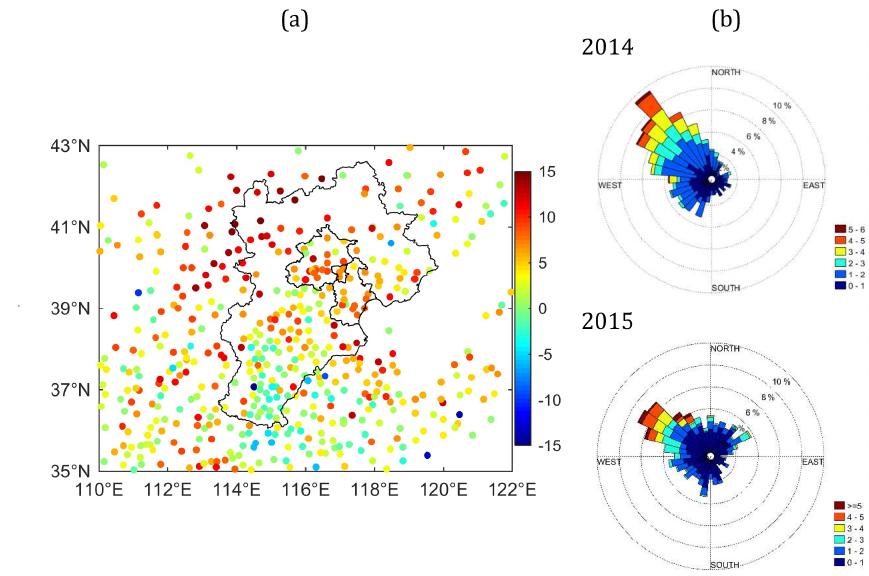
Figure 6. (a) The change in DSW (days) from December 2014 to December 2015 (December 2015–December 2014) and (b) wind rose maps in December 2014 and December 2015 over the BTH region. Table 2. Comparison of PM 2 . 5 concentrations in the Novembers of 2017 and 2018 from ambient observations and from CTM simulations by EMI-derived estimated emission changes. The emission ratio is indicated by bold font and the two concentration ratios are in bold italic font. City EMI 2 . 5 Observations Emission changed CTM simulated 2017 2018 2017 2018 O-Ratio E-Ratio 2017 2018 M-Ratio